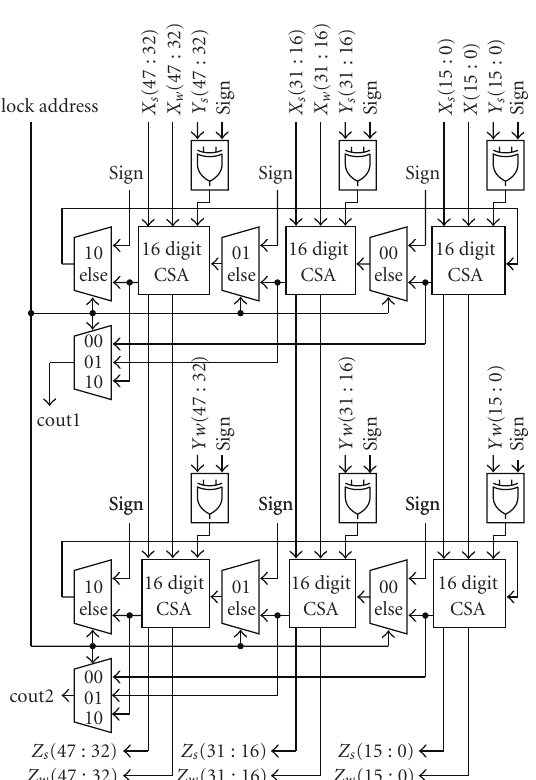
Figure 12: Central (4 : 2) CSA for operands.